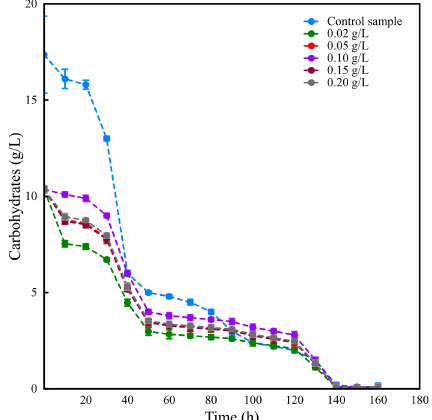
Figure 5. Decrease in the carbohydrate concentration in the control sample and pomace juice at different YSC